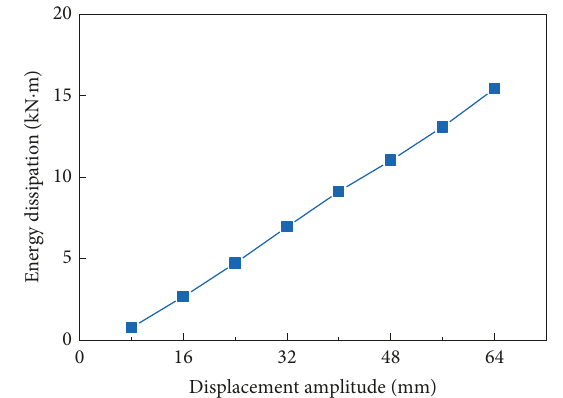
Figure 15: Energy dissipation vs. displacement amplitude curve.